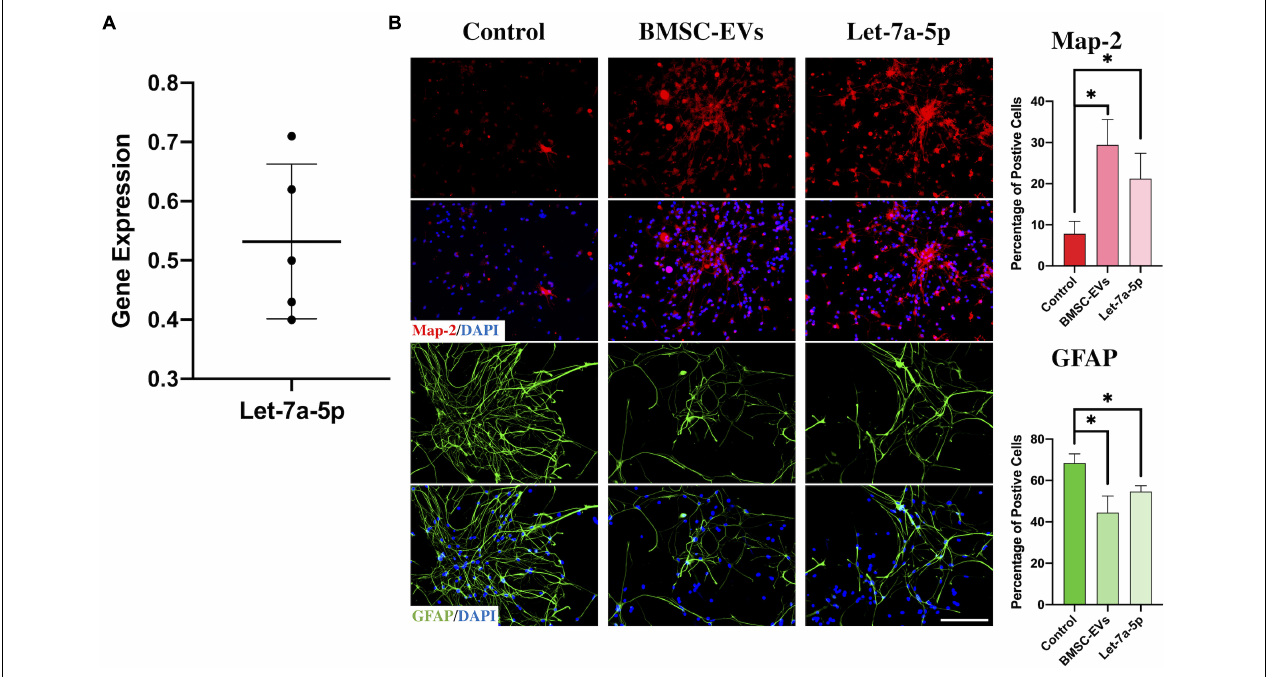
FIGURE 1 | BMSC-EVs and let-7a-5p promoted the differentiation of NSCs into neurons. (A) PCR confirmed the presence of let-7a-5p in BMSC-EVs ( n = 5). (B) The BMSC-EVs or let-7a-5p mimics were added to the NSCs and co-cultured for 7 days. The results showed that the percentage of Map-2 positive neurons was increased along with a reduction of GFAP positive astrocytes compared with the control groups by the addition of BMSC-EVs or let-7a-5p ( n = 5; data are mean ± S.D; Student’s t- test was used for comparisons. ∗ p < 0.05; scale bars, 100 µ